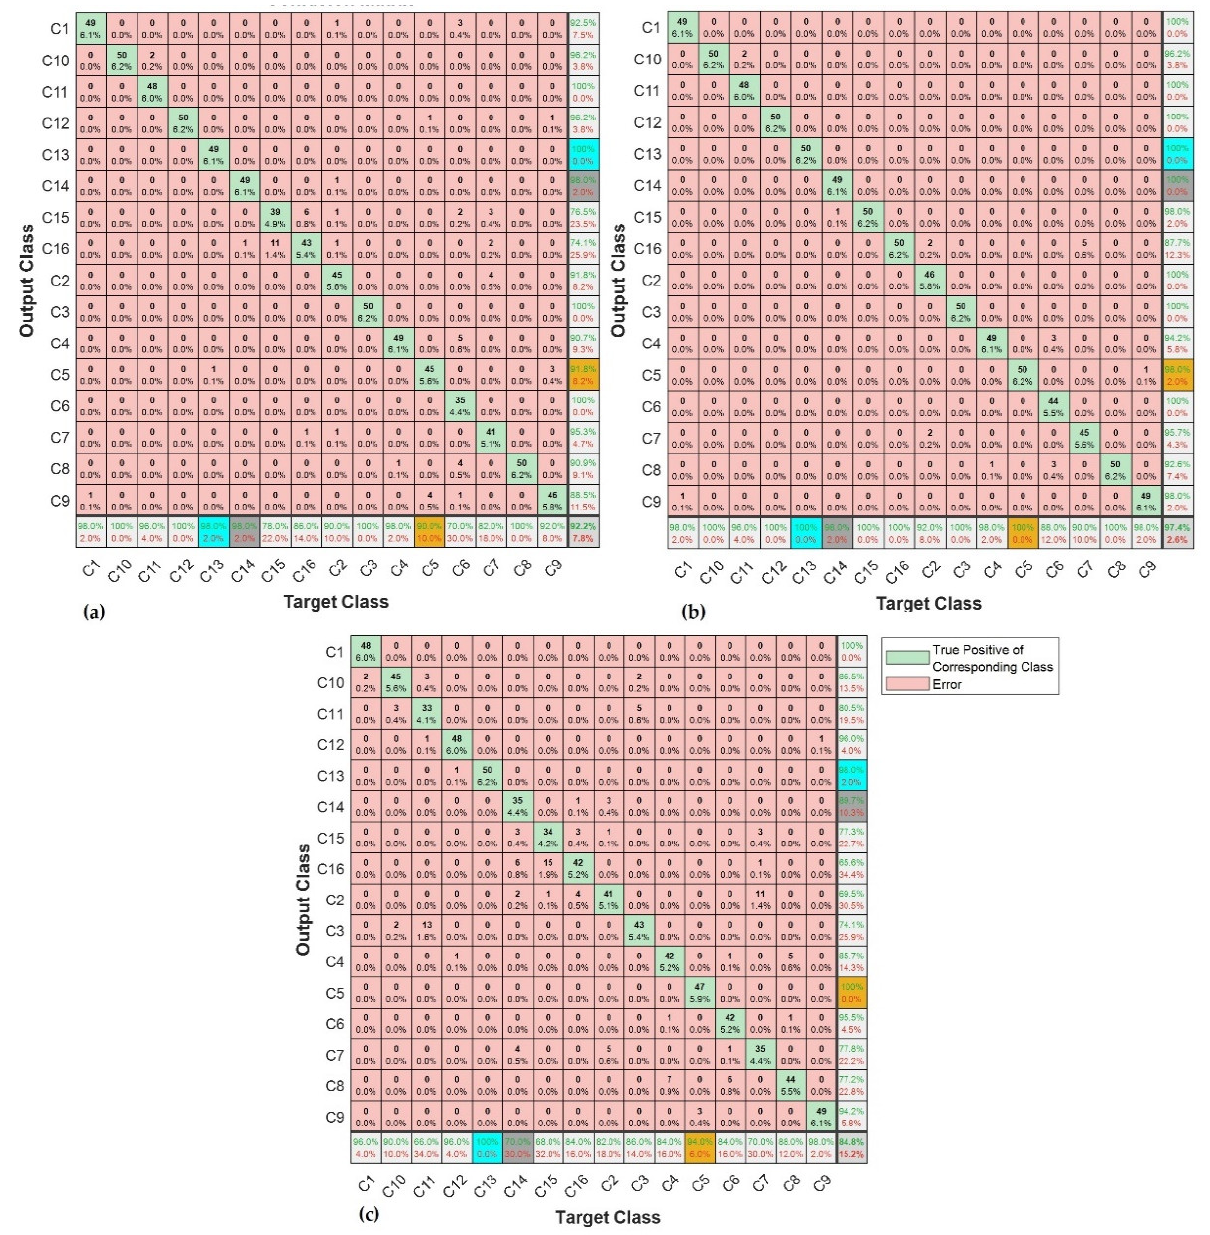
Figure 12. Performance of: ( a ) SK-CNN; ( b ) CSC-CNN; and ( c ) BICO-CNN.